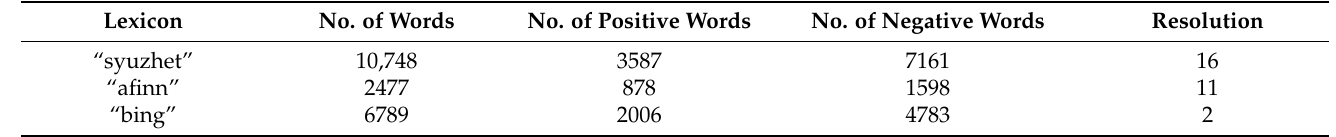
Table 3. Words in the “nrc” lexicon.